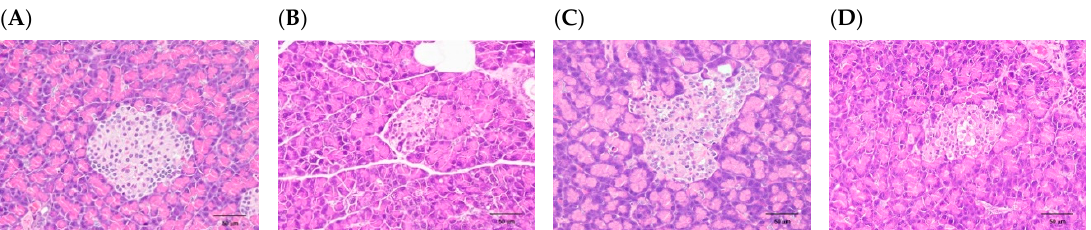
Table 2. Biochemical analysis of T2DM rat model after treatment with HC and SO for 28 days. Group Sham Control HC SO Number of Animals 8 Cholesterol mg/dL HDL: low-density lipoproteins cholesterol; LDL: low-density lipoproteins cholesterol. Data are expressed as the mean ± SD. Significant difference between the control-treated group at * p < 0.05, ** p < 0.01 by one-way ANOVA.